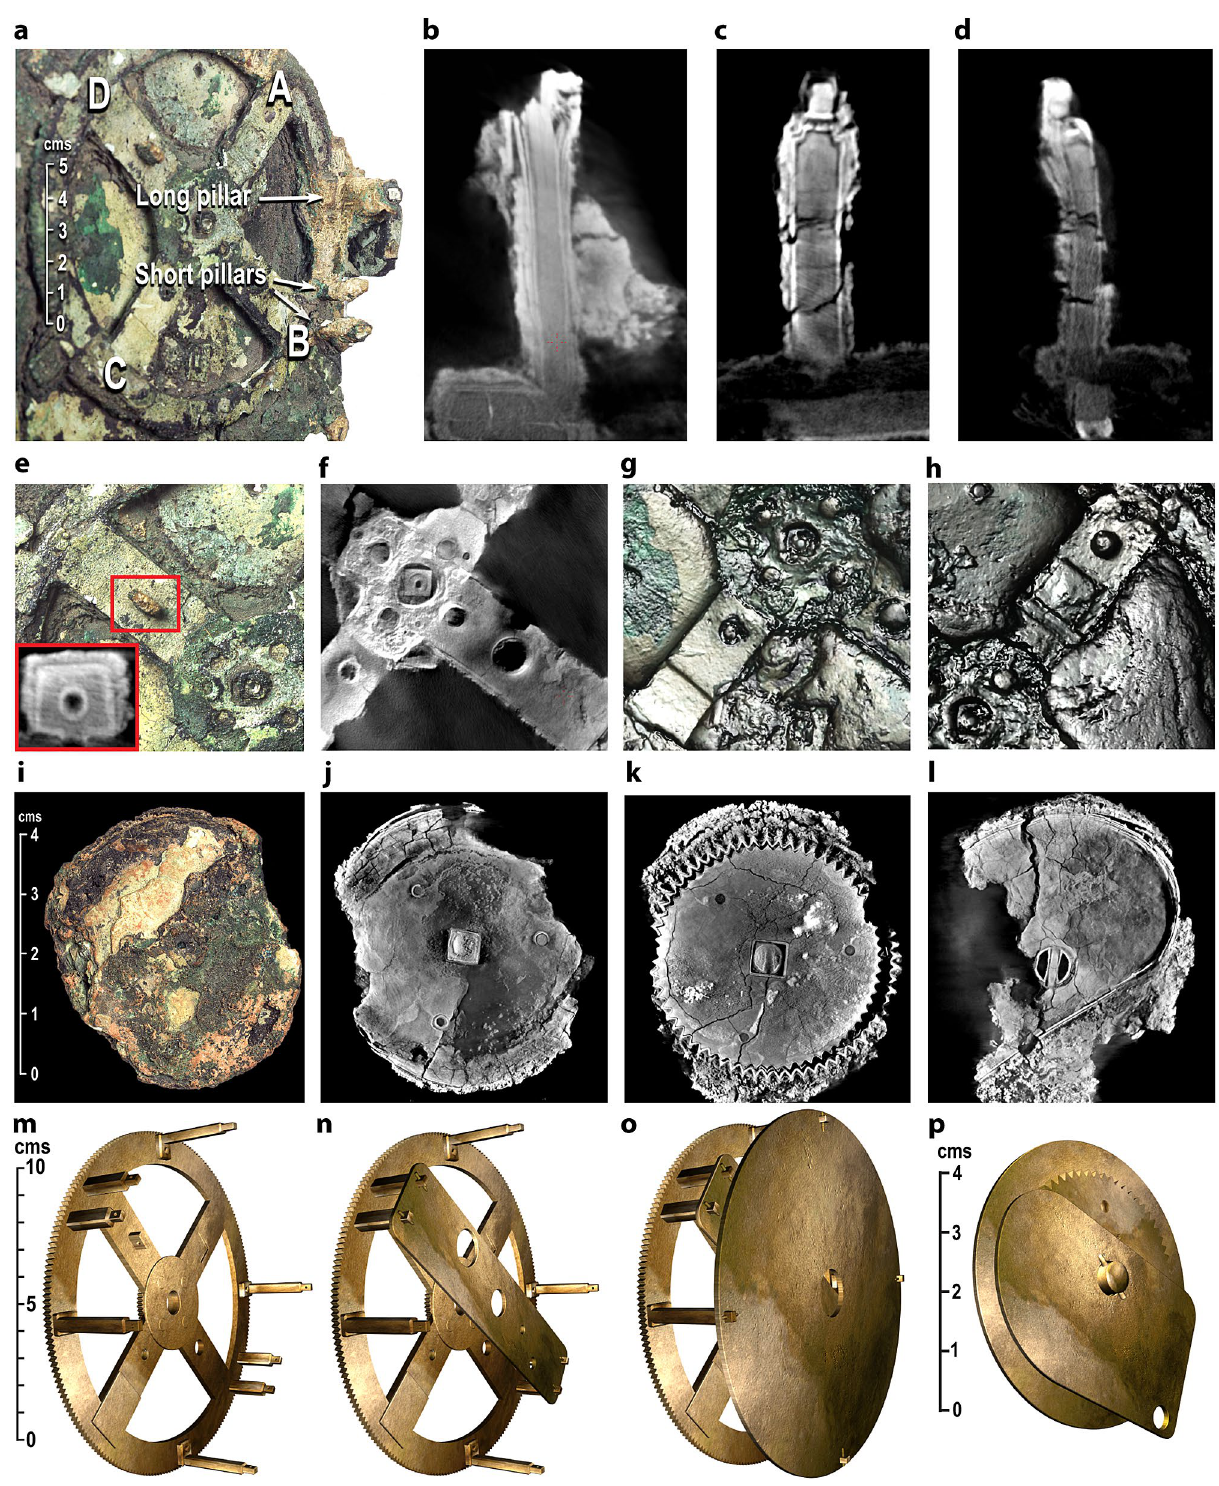
Figure 4. Evidence from Fragments A & D. Reconstructed plates and gear. ( a ) Photograph of Fragment A, showing pillars on the periphery of b1 and features on Spokes A, B, C, D. ( b ) X-ray CT of long pillar. ( c – d ) X-ray CT of short pillars. ( b – d ) are from an improved X-ray volume 22 . All pillars have shoulders and pierced ends. ( e–h ) Photographs, PTMs, X-ray CT: features on Spokes D, B, C, A, including holes, circular depressions and flattened areas. In ( E ), the pierced block on Spoke D is highlighted in red, with inset showing X-ray CT slice through the block. ( i - l ) Photograph & X-ray CT of Fragment D, showing a disk , gear and plate . ( m – o ), Computer reconstruction, showing b1 , Strap on the short pillars; Circular Plate ( CP ) on the long pillars. ( p ) Computer reconstruction of the features in Fragment D, which we reconstruct as the epicyclic components of a Venus